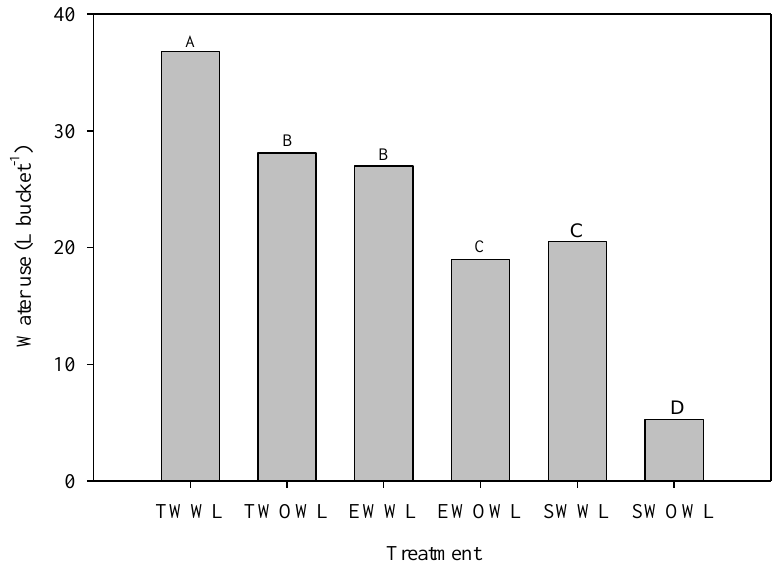
FIGURE 2. Effects of irrigation methods on water use in the pot simulation experiment. TWWL = transpiration with water layer; TWOWL = transpiration without water layer; EWWL = evaporation with water layer; EWOWL = evaporation without water layer; SWWL = seepage with water layer; SWOWL = seepage without water layer. Different letters at the top of the bars indicate significant difference ( p < 0.05).